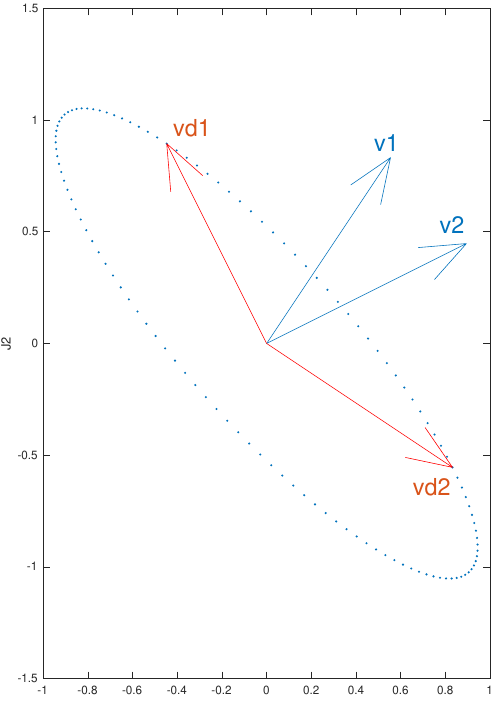
Figure A1. Ellipsoid representing the unit circle in the norm associated with the dominance basis. The preference directions fixed by the DM are shown (blue). The corresponding dominance basis is also shown